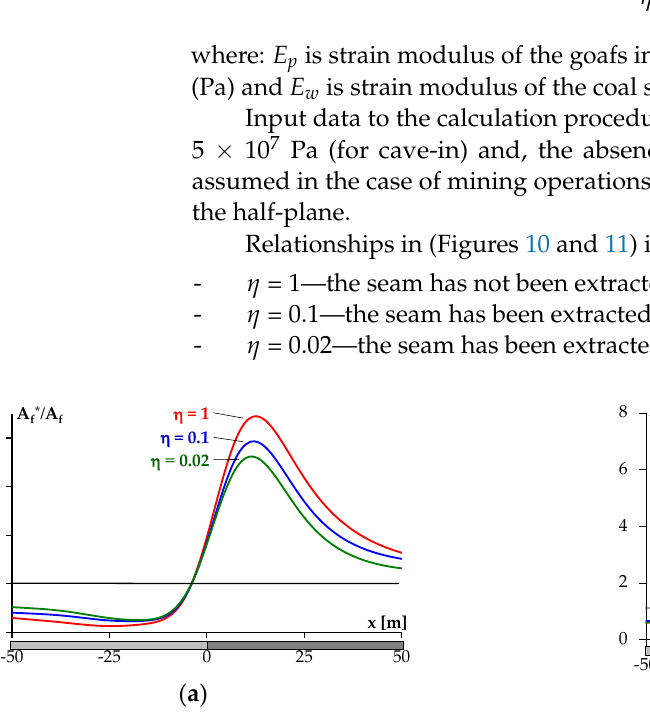
Figure 10. Distribution of the energy concentration coefficient for shear strain for different cases of seam extraction in the area: ( a ) the exploitation edge, ( b ) the residual pillar.